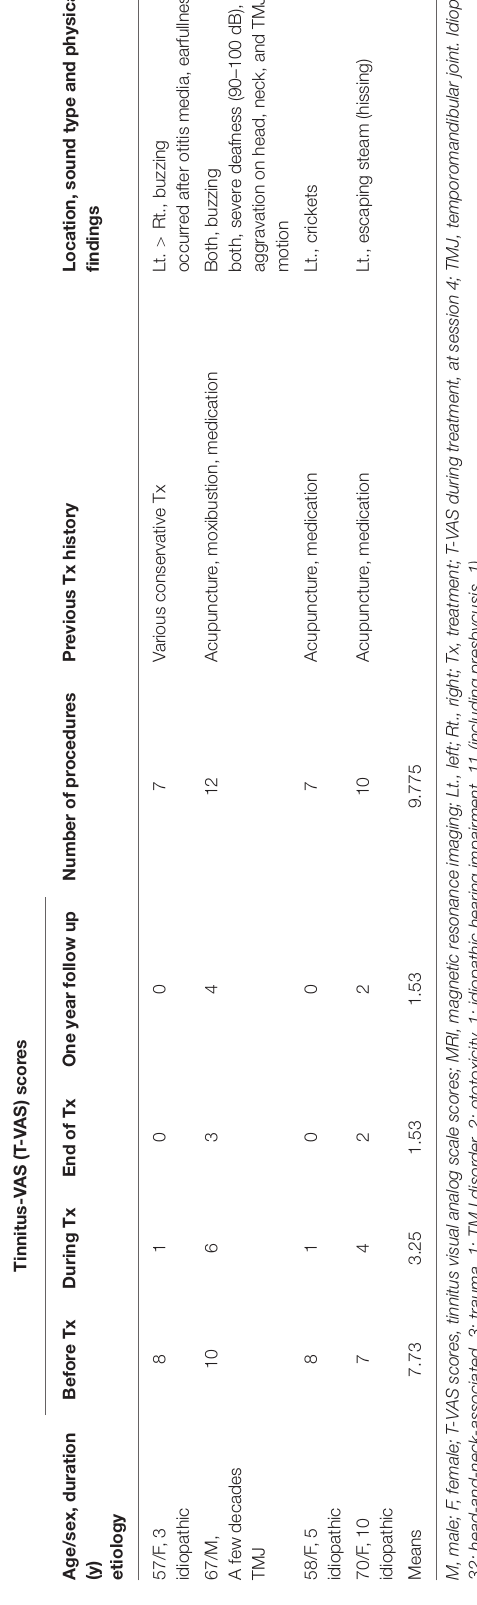
FIGURE 3 | Shown are the novel 1. 9-, 2. 2-, and 3.8-cm-long, thin, 30-G hypodermic needles with needle hub caps used in the present procedures.